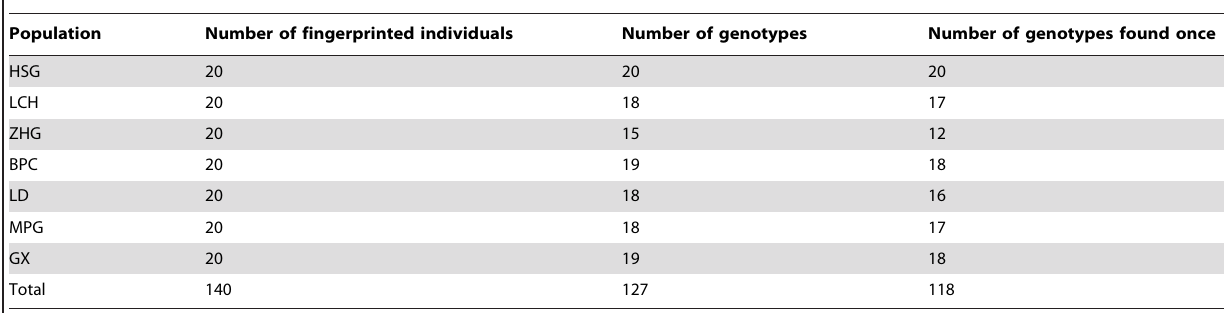
Table 4. Summary of ISSR genotype characters for each population.